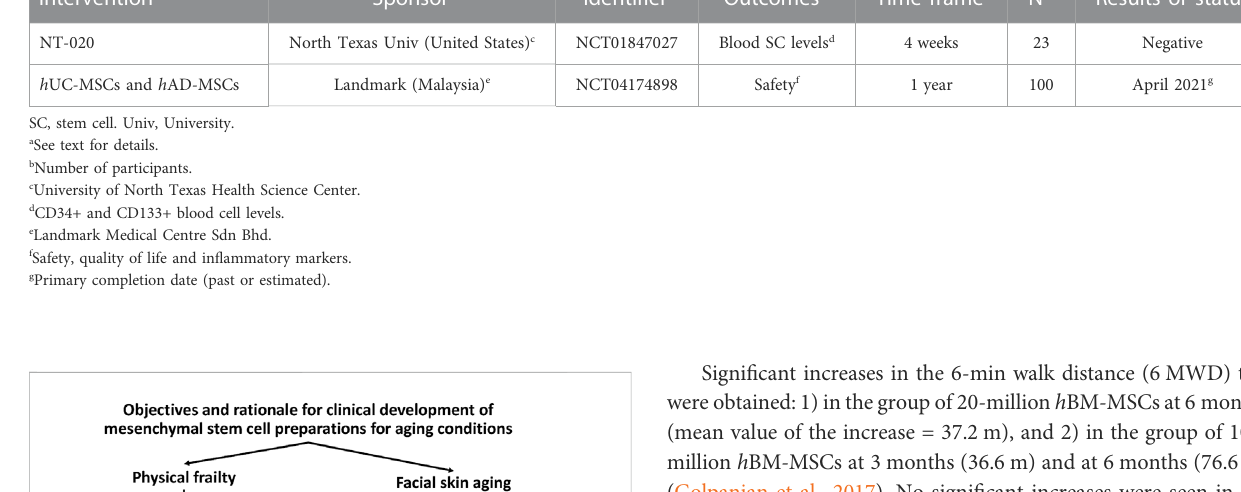
TABLE 3 Other clinical trials with stem cell preaparations for aging (2019 and later). Intervention